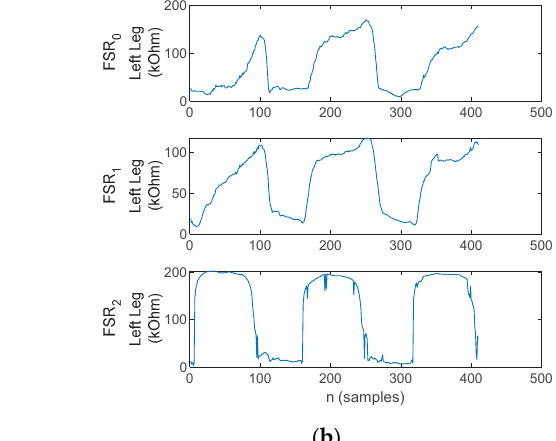
Figure 15. The FSR waveforms ( FSR 2 —heel, FSR 1 —metatarsal arch, FSR 0 —toe) during the walking trials for ( a ) healthy control—exhibits the physiological heel → metatarsal arch → toe pressure progression pattern, and ( b ) Patient 5—exhibits flat-foot strike as pressure is applied simultaneously on all three FSRs. Lift-off accounts for the fact that the foot is lifted from the ground during the swing phase, and consequently stance phase with the opposite foot. Accordingly, no plantar pressure should be recorded during the swing phase, provided the foot is fully lifted from the ground, accounting for the identification of lift-off. For illustration, the FSR signals during sway, with lift-off and without lift-off, are plotted in Figure 16.